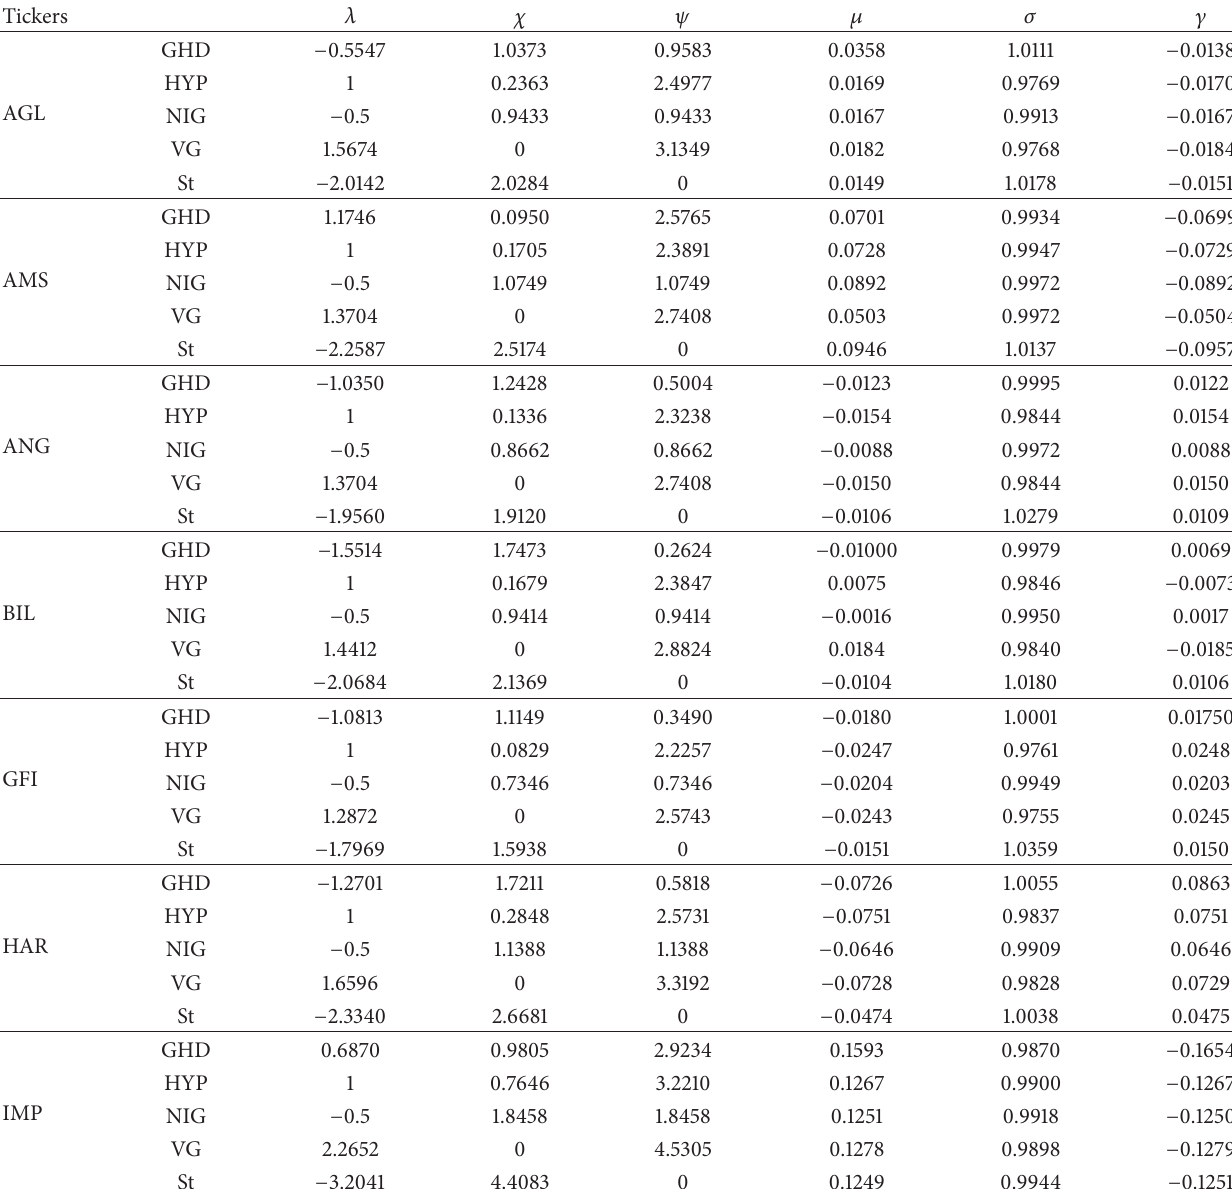
Table 2: Univariate estimation parameters.